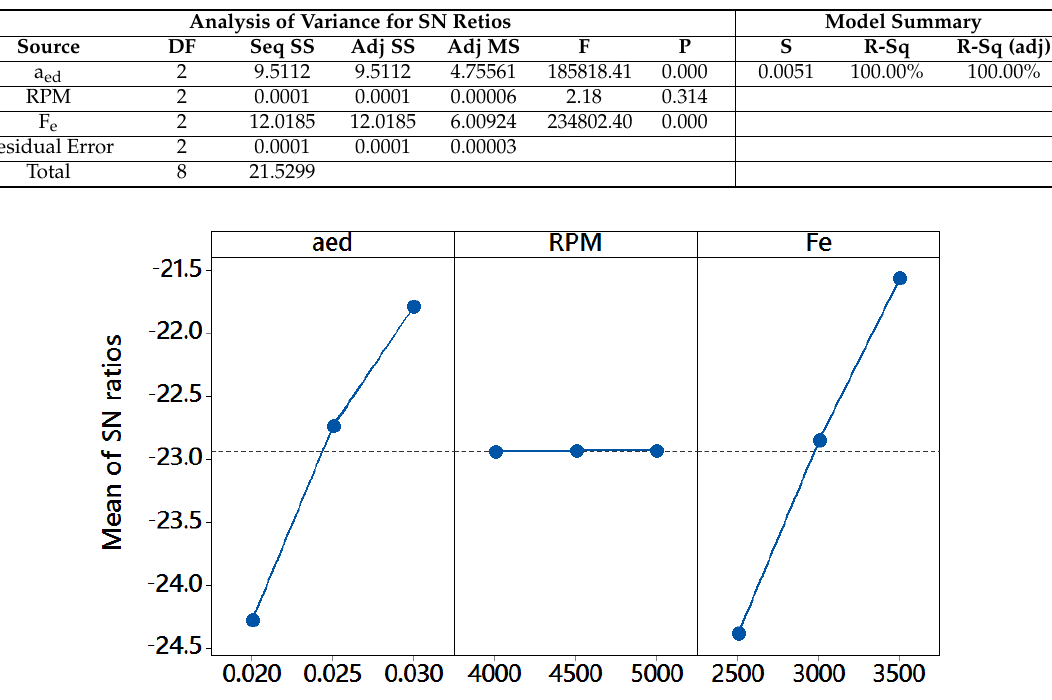
Figure 3. Main effect plots of cutting parameters for S/N ratios.